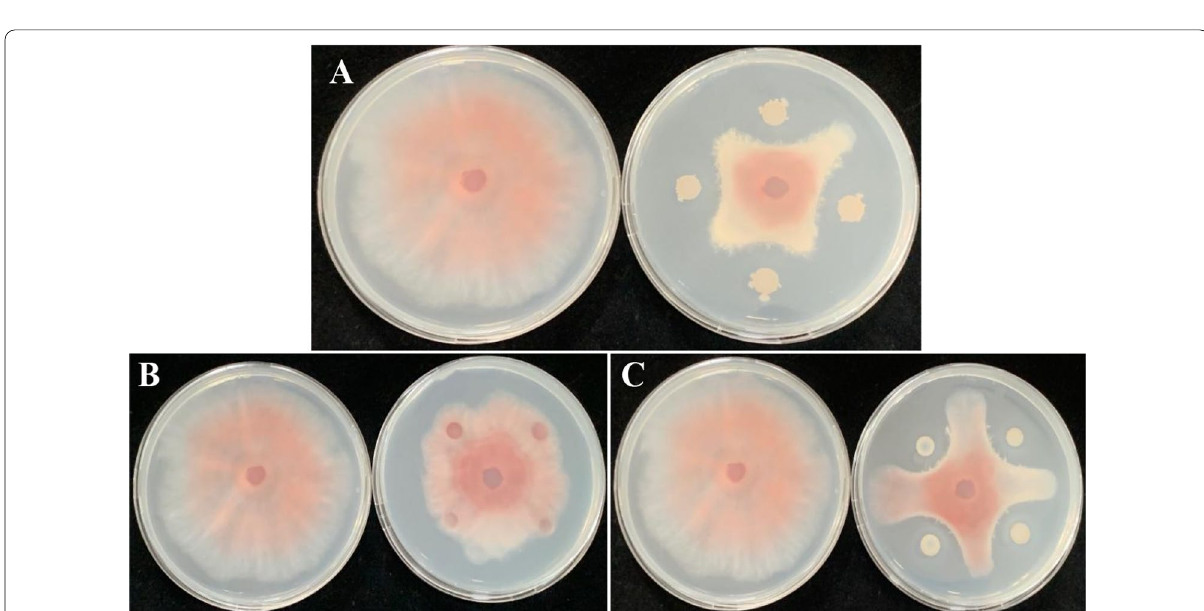
Fig. 2 Antagonistic effects of different strains against Fusarium oxysporum . A Antagonistic activity of the strain Gxun-6; B Antagonistic activity of the strain Gxun-4; C Antagonistic activity of the strain